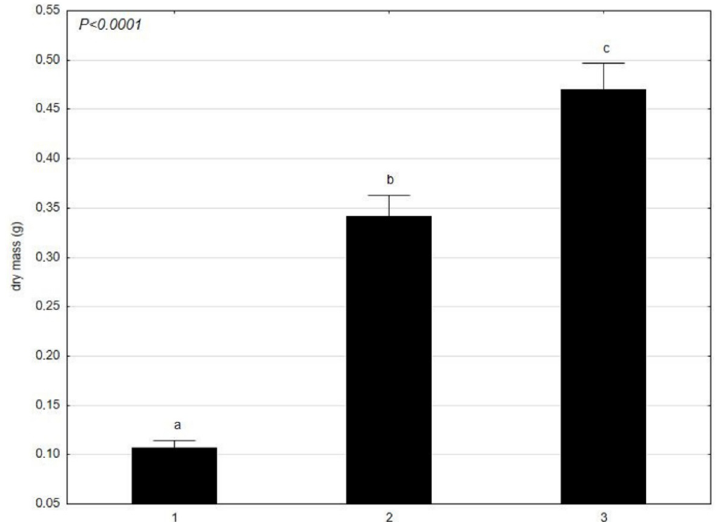
Figure 6. Mean value of dry mass (g) of L. minor in different times (1–30 April 2021; 2–4 June 2021; 3–17 July 2021) presented using the Tukey multiple comparisons test. The bars indicate mean values. Error bars represent standard error. A, B, C determines the statistical significance between the analyzed features. A statistically significant result for p ≤ 0.05 was marked.